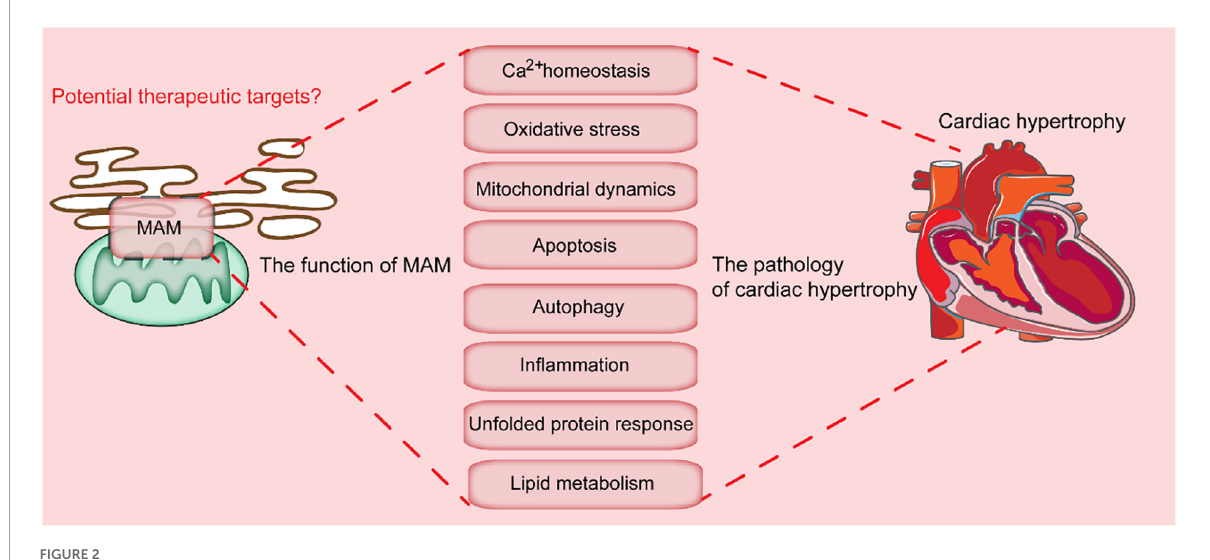
FIGURE2 Key cellular processes mediated by MAMs-localized proteins. MAMs are involved in multiple cellular processes, which include calcium homeostasis, oxidative stress, mitochondrial dynamics, apoptosis, autophagy, inflammation, unfolded protein response, and lipid metabolism. Dysregulation of these processes leads to the progression of cardiac